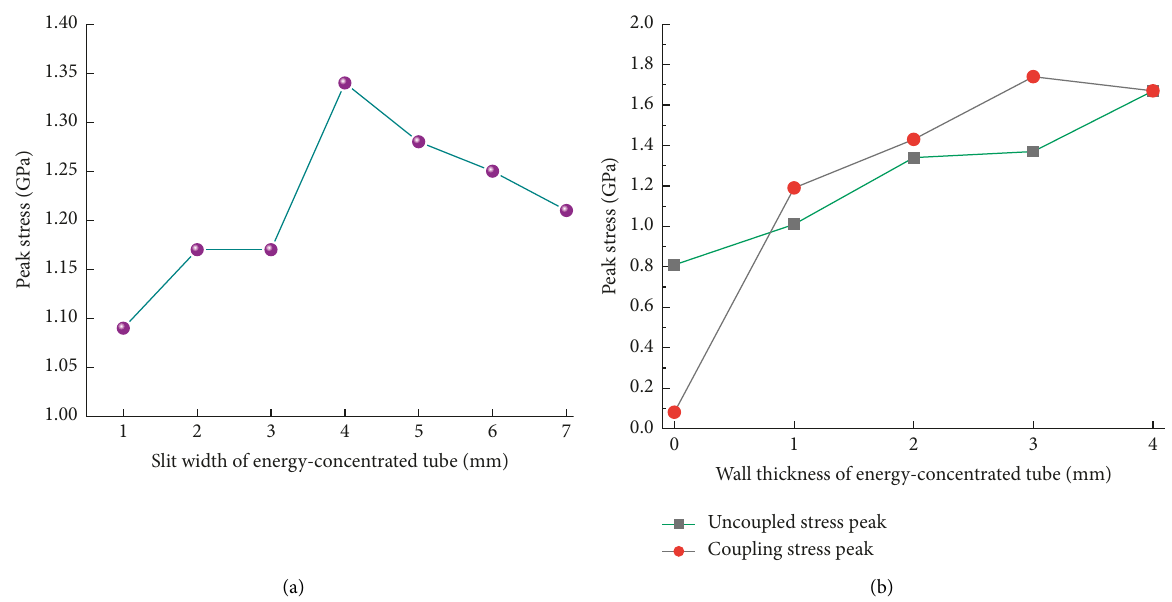
Figure 21: Relation curve between peak stress and (a) slit width and (b) wall thickness [12].